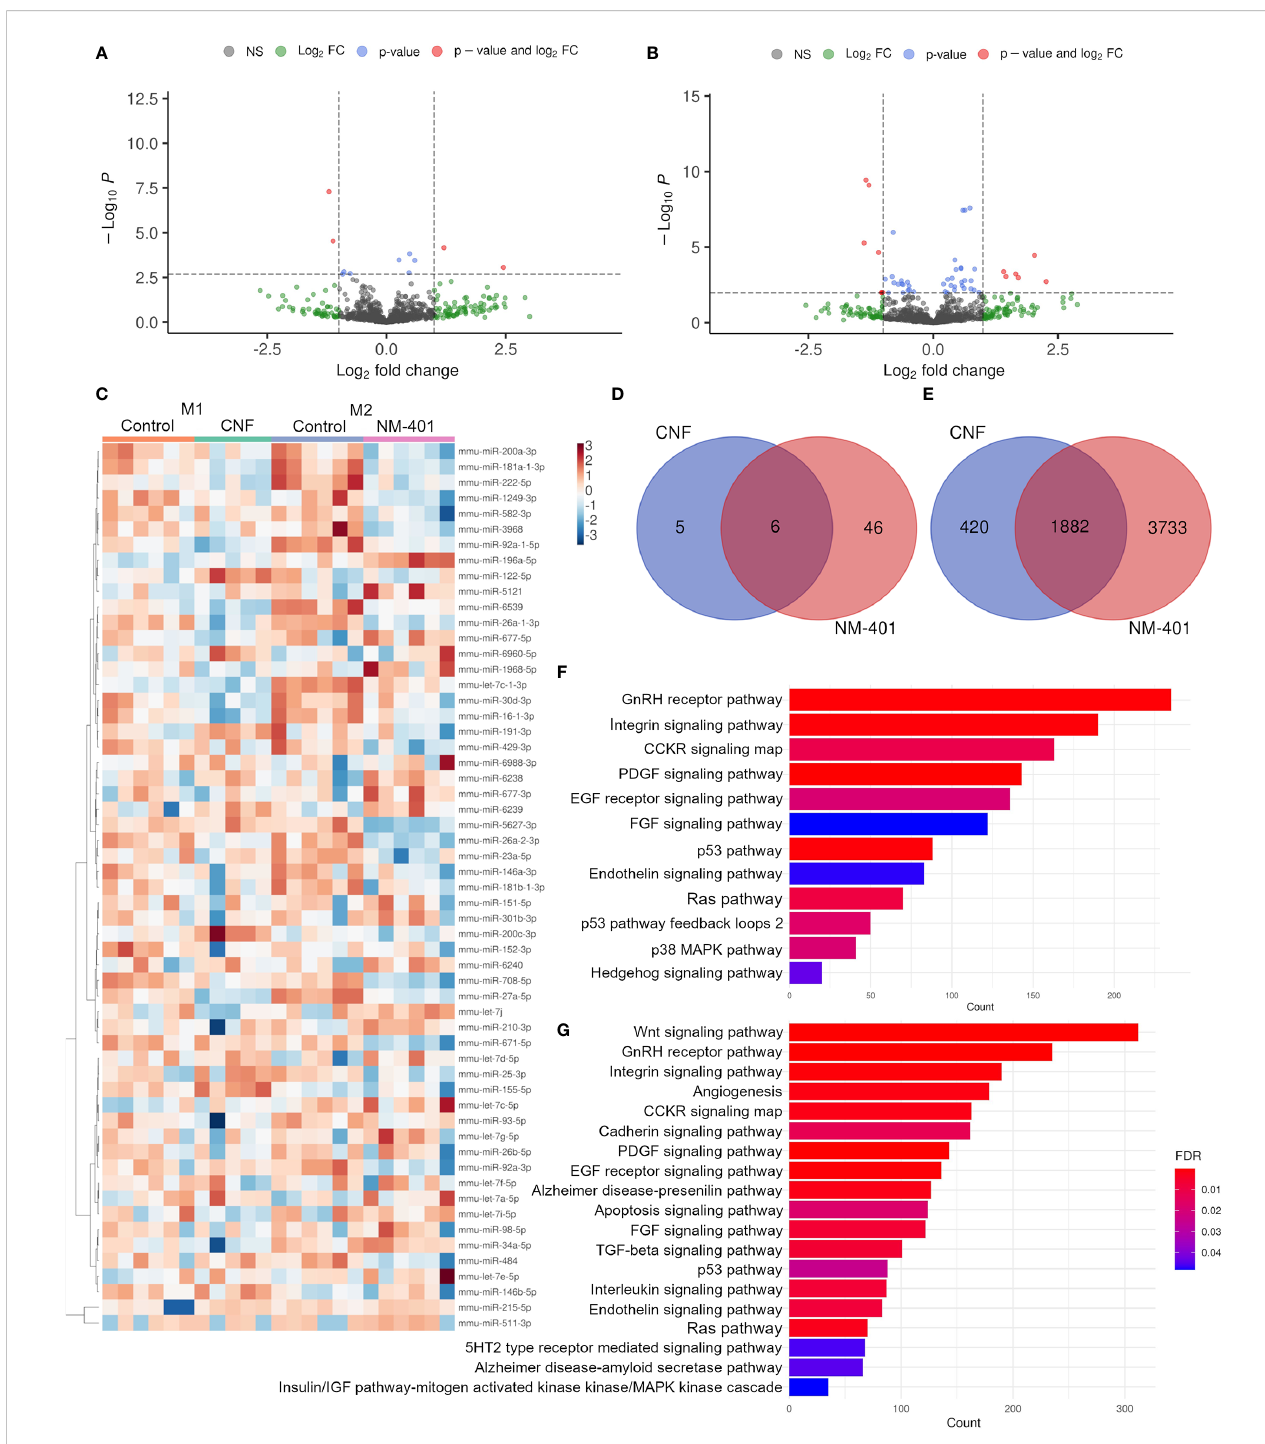
FIGURE 6 CNF and NM-401 exposure induced changes in miRNA expression. (A) Volcano plot of differentially expressed known miRNAs in CNF-exposed M1 cells. (B) Volcano plot of differentially expressed known miRNAs in NM-401-exposed M2 cells. Y-axes show negative decadic logarithm of uncorrected p- values (-log10 P), x-axes show the binary logarithm of fold changes (log2 fold change). Log2 fold change cutoff = 1, and FDR cutoff = 0.1 are indicated. (C) Clustering heat map of differentially expressed miRNAs -log 10 (CPM). (D) Venn diagrams of differentially expressed miRNAs and (E) their predicted target genes. PANTHER analyzes of the target genes of differentially expressed miRNA in (F) CNF- and (G) NM-401-exposed macrophages,